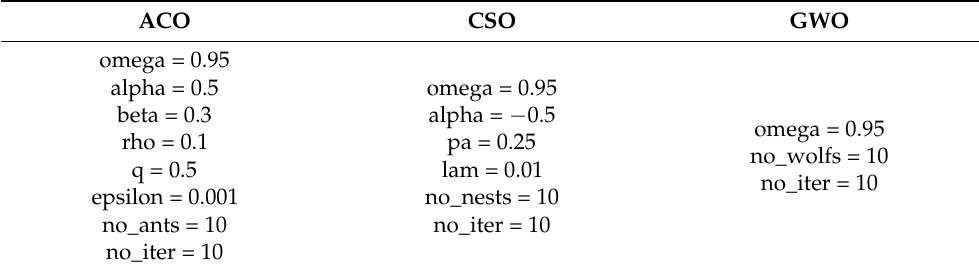
Table 10. ACL, CSO, and GWO free parameters for all the experiments.